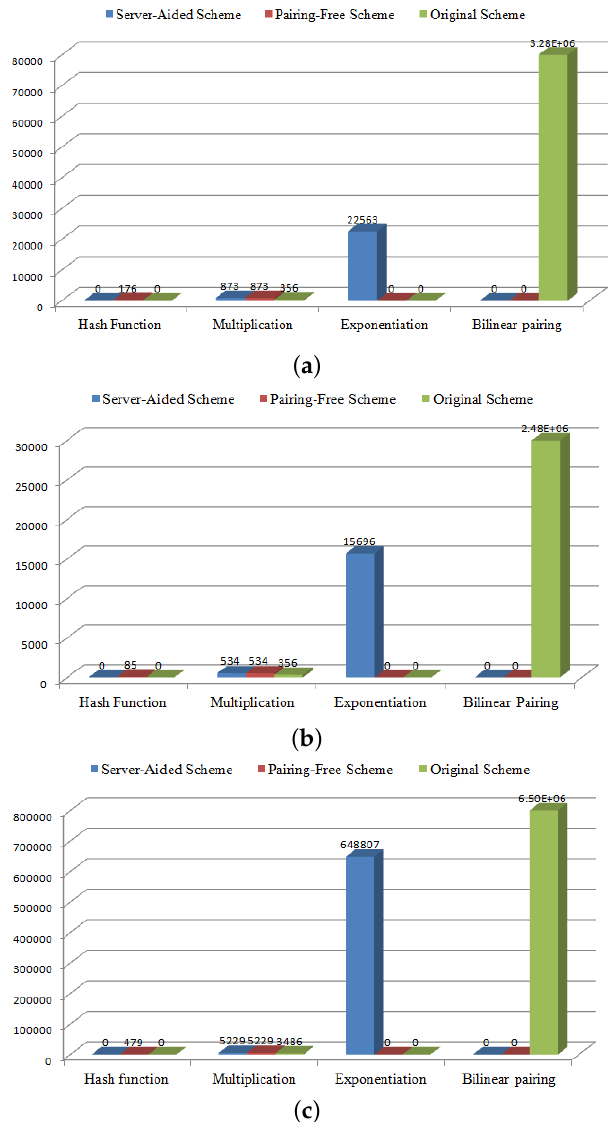
Figure 5. ( a ) Efficiency comparison in smartwatch platform; ( b ) efficiency comparison in smartphone platform; ( c ) efficiency comparison in embedded device Raspberry Pi 1 Model